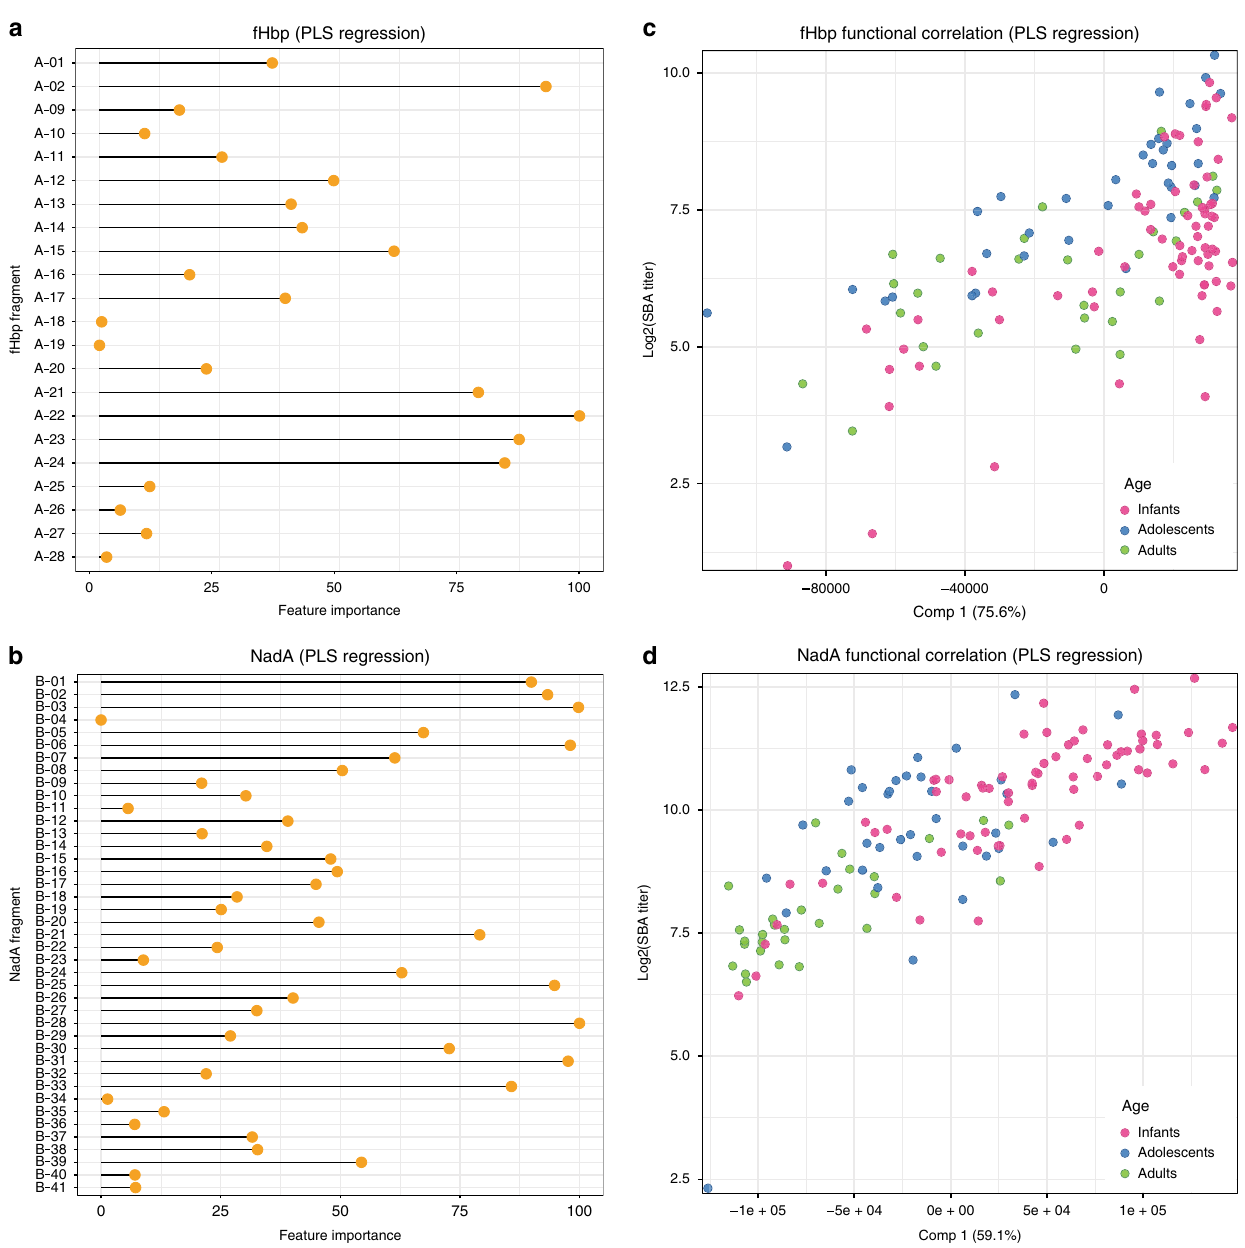
Fig. 5 Correlation of bactericidal activity with speci fi c or general protein array reactivity. Panels a and b respectively represent the single fHbp and NadA fragments contribution to the PLS regression model of the SBA outcome through MFI fragment signals. The fragment importance score corresponds to a weighted sum of the absolute regression coef fi cients, values> 75% suggest the relevant predictors of the model. Scatterplots of the absolute value of global MFI fi rst PLS component scores against the log2 of SBA titres for respectively fHbp (panel c ) and NadA (panel d ) antigens in all age groups. Source data are provided as a Source Data fi